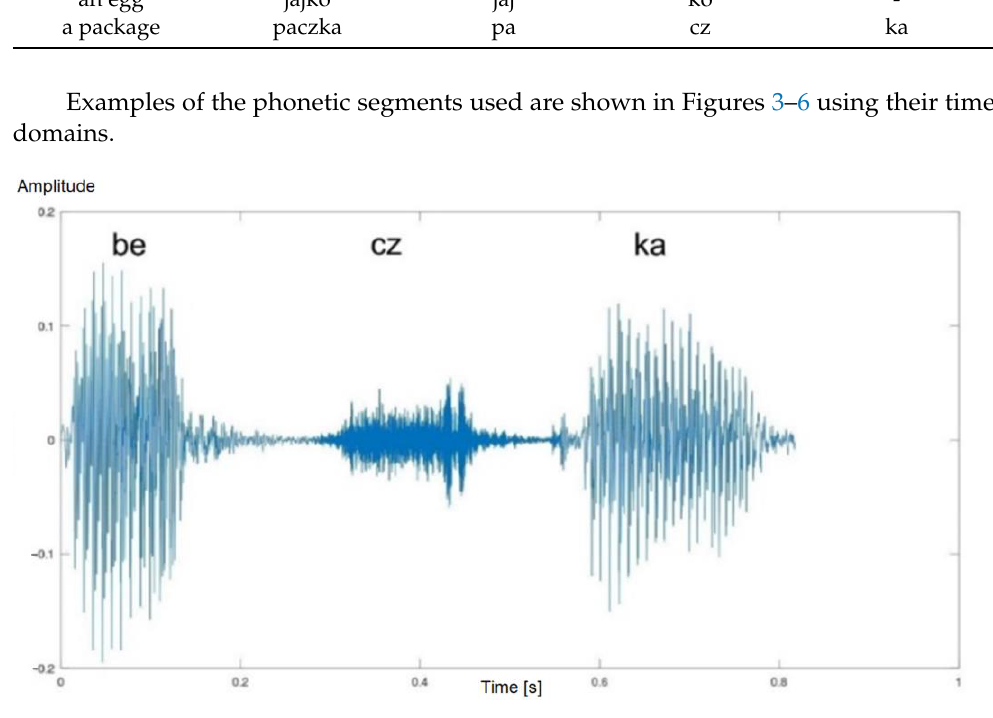
Figure 3. Time waveform of the word “beczka” (eng. a barrel)—healthy man. Three phonetic segments are visible.